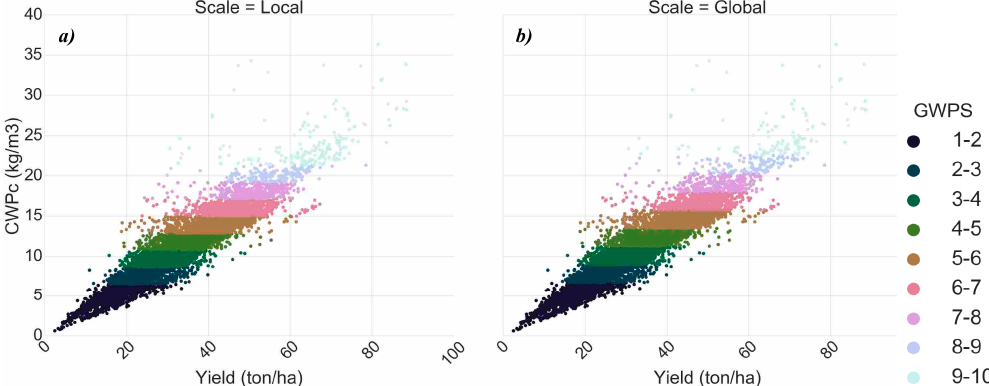
Figure 6. CWPc plotted against yield identifying score clusters for the GWPS setting for ( a ) local Palestinian 99th percentile set as the target and the ( b ) global 99th percentile derived from literature set as the target.